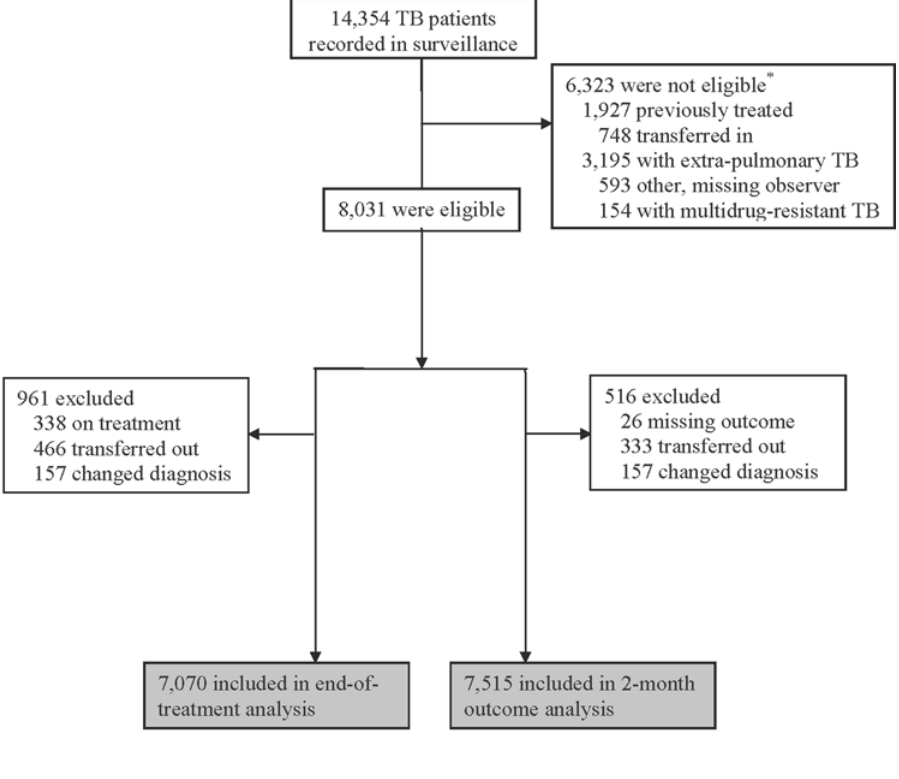
Figure 1. Patients included in the analysis.